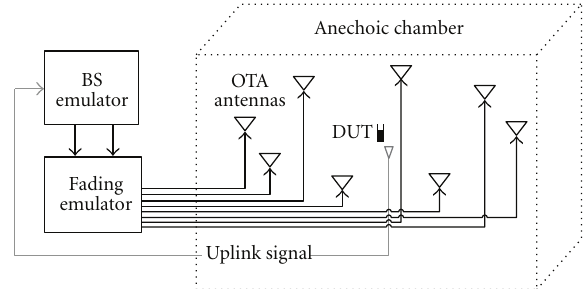
Figure 1: Fading emulator and anechoic chamber based MIMO OTA test set-up.